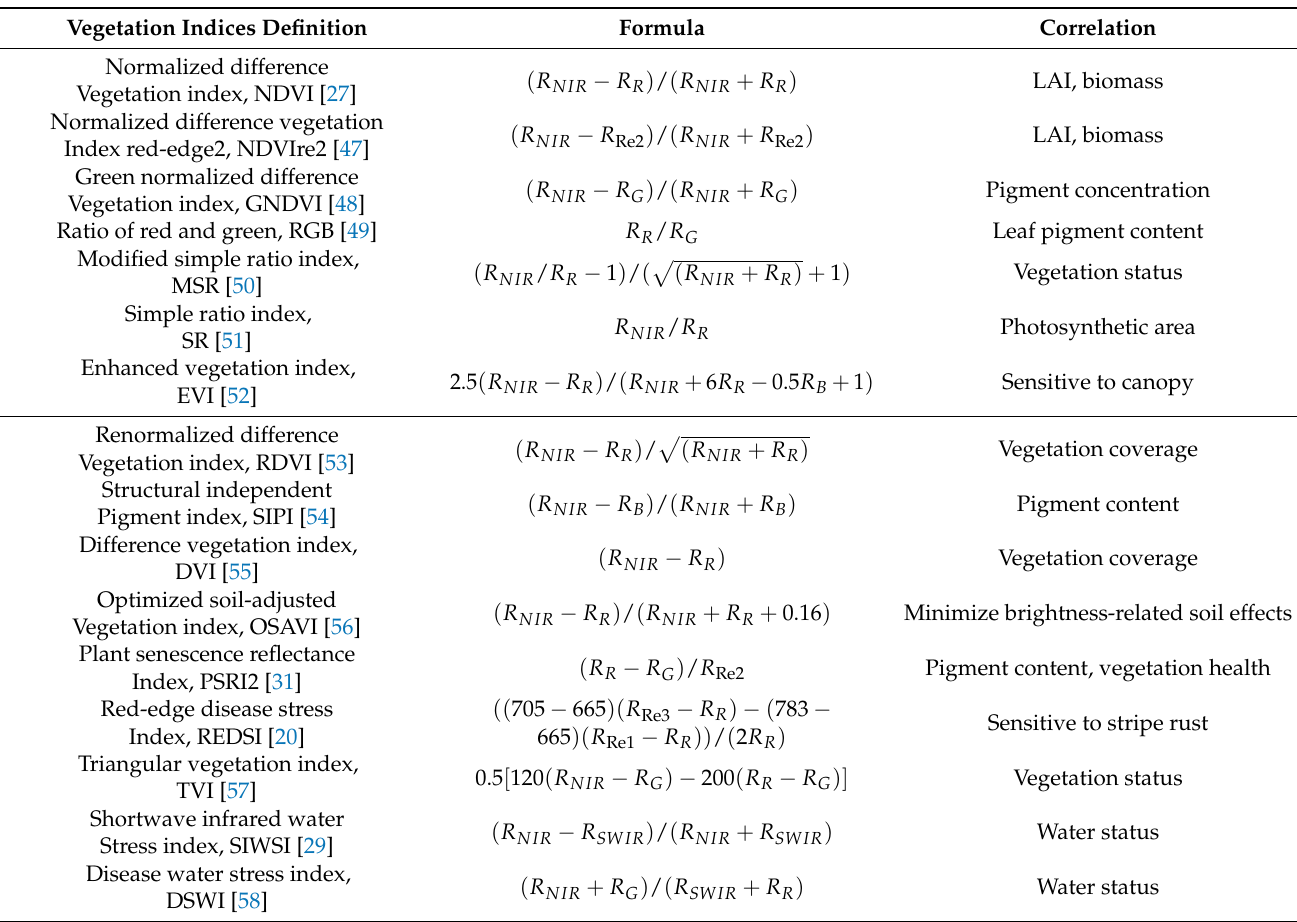
Table 1. Vegetation indices used for stripe rust predictions. These vegetation indices were used as candidate features. Vegetation Indices